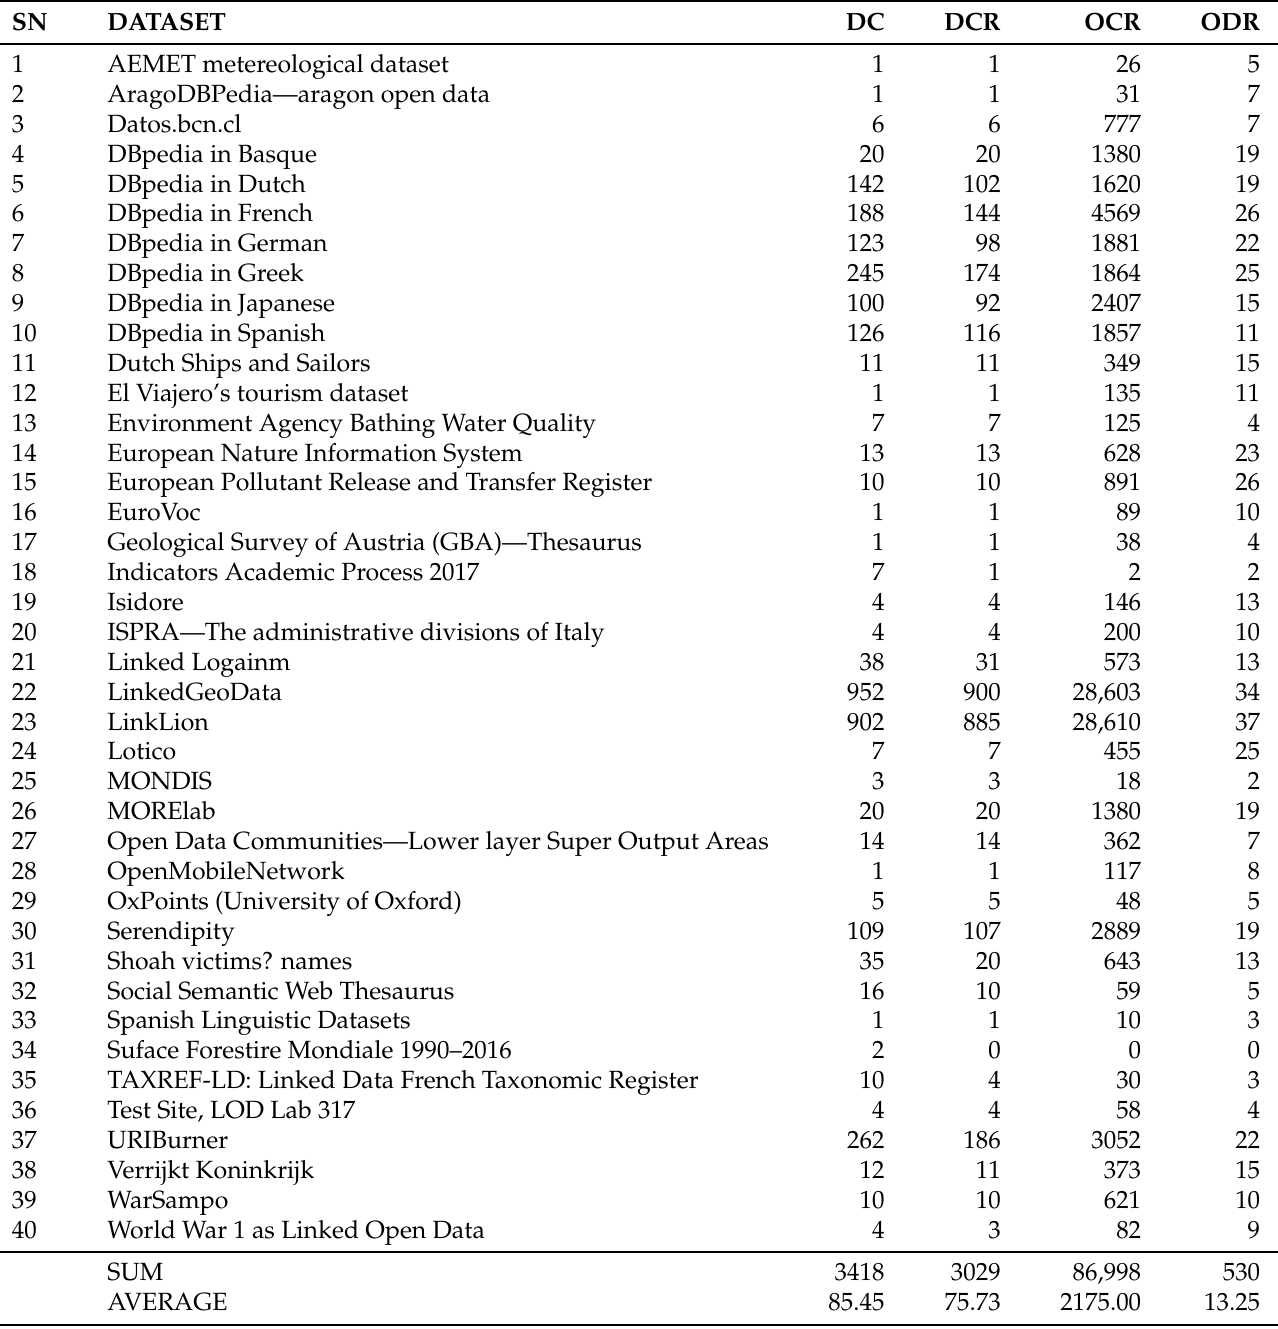
Table 5. GeoLOD Recommendations statistics (DC = Number of dataset classes, DCR = Number of dataset classes for which there are recommendations, OCR = Number of recommendations to other dataset classes, ODR = Number of recommendations to other